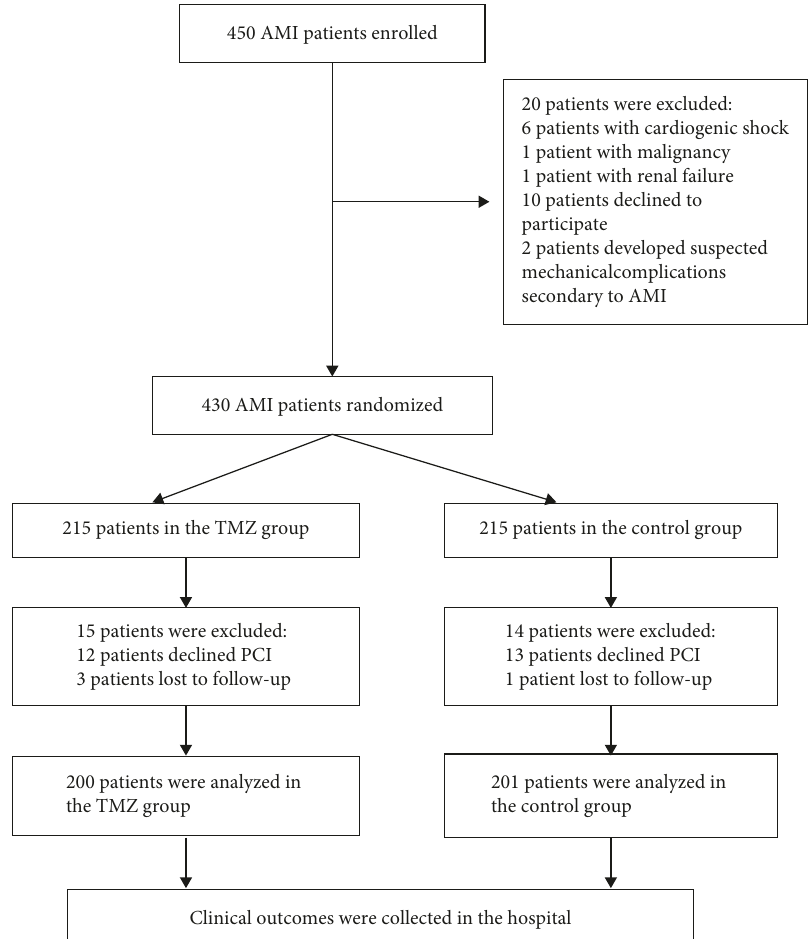
Figure 1: Flowchart of patient enrollment. PCI, primary percutaneous coronary intervention; AMI, acute myocardial infarction; TMZ,